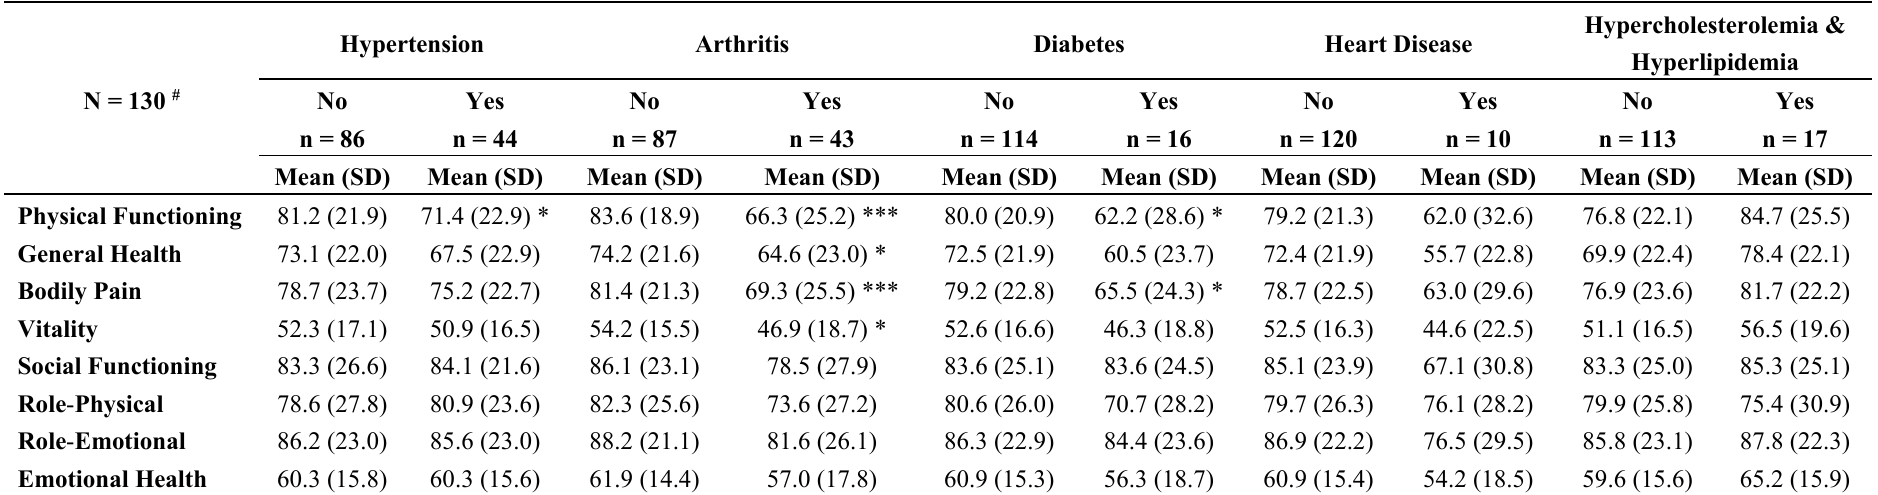
Table 3. Quality of Life: SF36v2